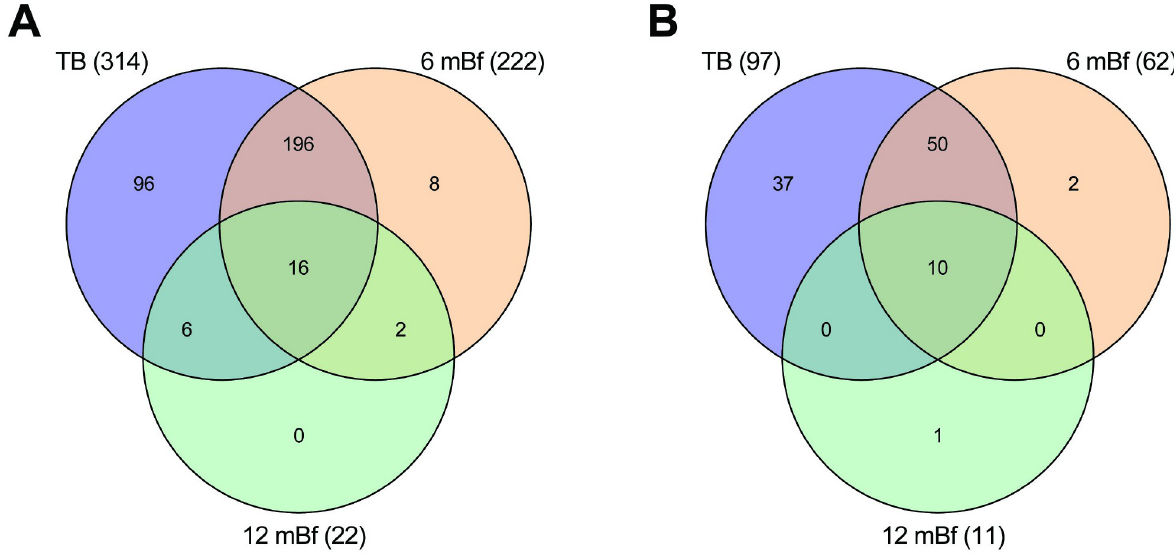
Fig 5. Venn diagram of the overlap in significantly upregulated genes that are annotated to function in: A) neutrophil degranulation, and B) NET formation. Differentially expressed genes at 7–12 and 1–6 months before diagnosis and in TB patients in contrast to the non-TB time zero baseline group from the GC6-74 study. The numbers in parenthesis indicate the total numbers of upregulated genes at the time point.